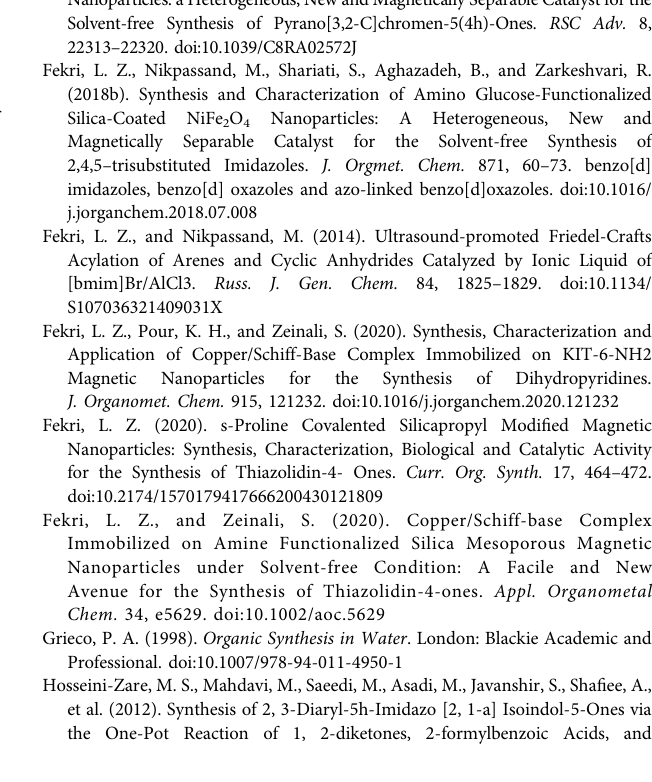
Frontiers in Chemistry |